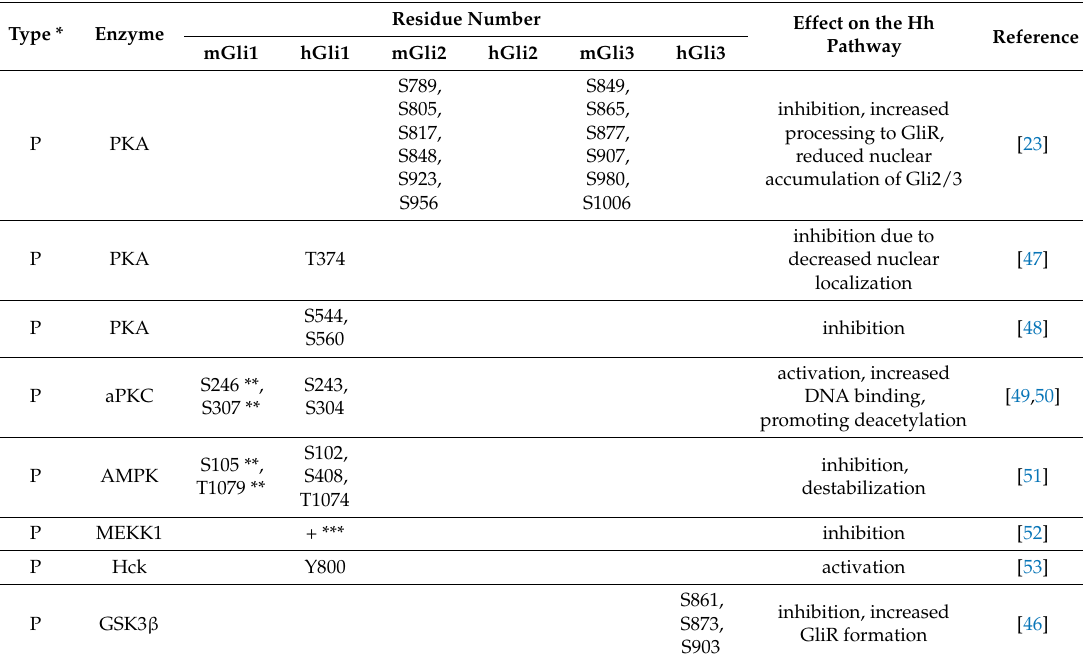
Table 1. Posttranslational modifications of Gli